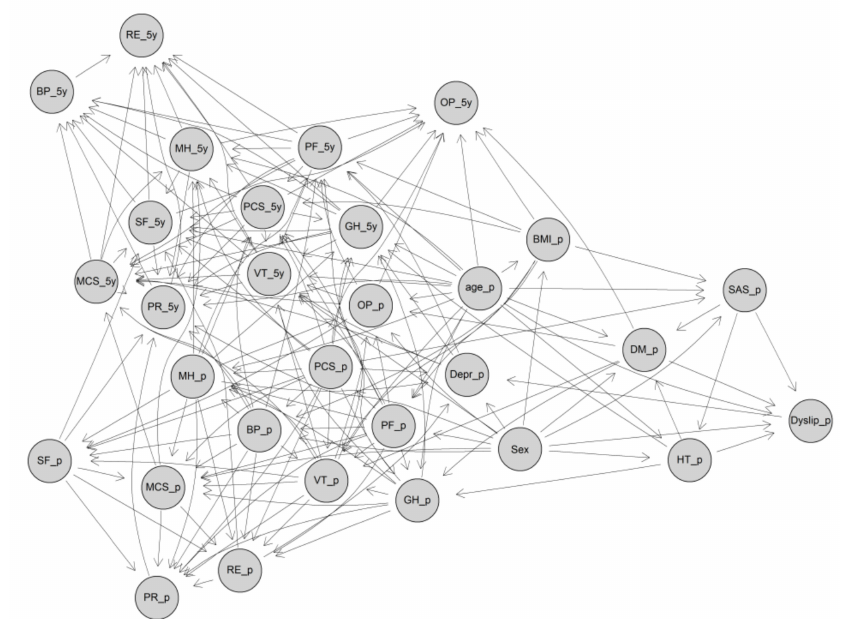
Figure 1. The directed acyclic graph (DAG) of the GBN for predicting postoperative 5-year HRQoL scores. DAG, directed acyclic graph; GBN Gaussian Bayesian network; PF, physical functioning; RP,